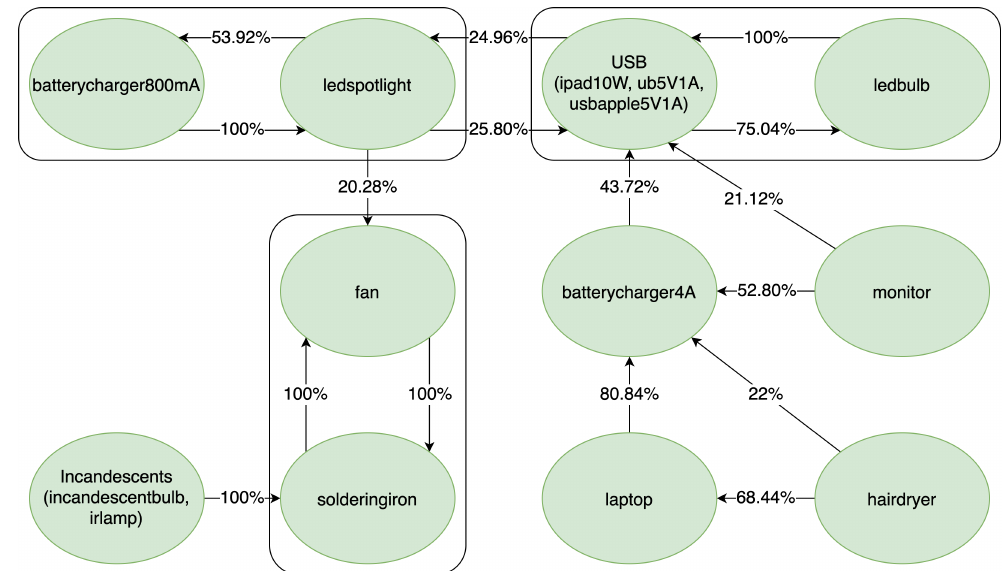
Figure 4. Clustering of load classes based on where the CNN model would classify the unknown class. Only those mappings that contained (on average) at least 50 samples (20% of all samples) are